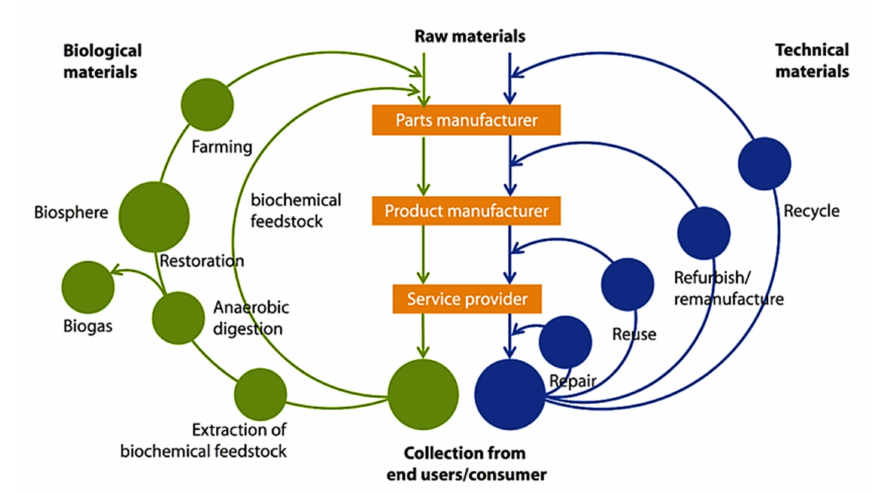
Figure 1. Circular economy butterfly diagram (adapted from EMF (2013)